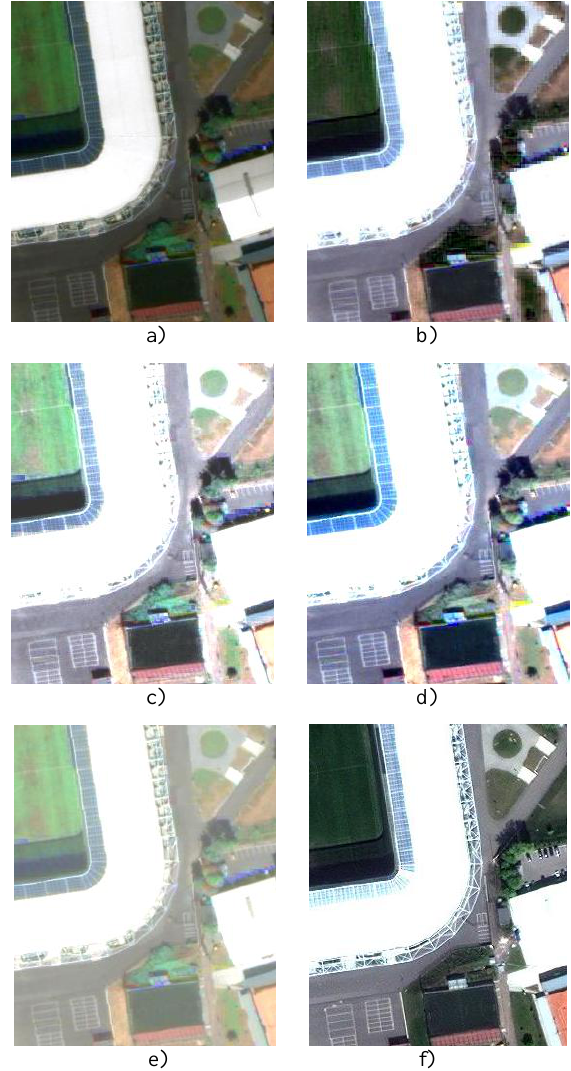
Figure 6. The results of different classic fusion methods (a) Brovey, (b) Gram-Schmidt, (c) PCA, (d) ICA, (e) HSV, (f)